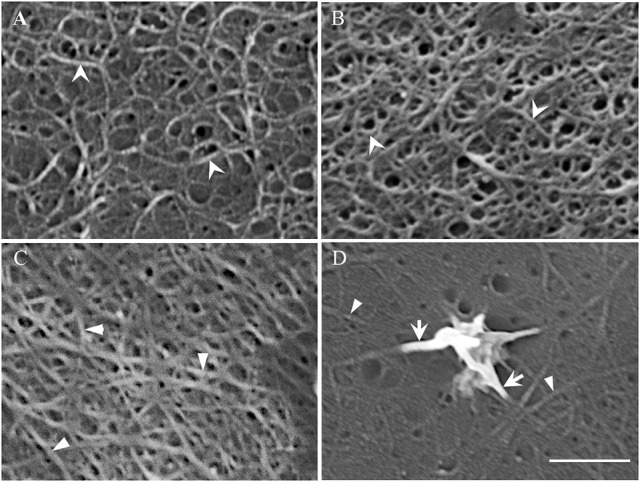
Field emission scanning electron micrographs of cellulose microfibrils viewed from the cytoplasmic face of the outer periclinal wall of adaxial epidermal cells. (A,B) Micrographs of the original wall layer obtained from (A) freshly harvested cotyledons and (B) cotyledons cultured for 15 h on 100 μM DPI to block uniform wall layer formation. (C,D) Micrographs of a fully-developed uniform wall layer obtained from cotyledons cultured for 15 h on MS medium alone. (D) In order to improve visualization of the thickened cellulose microfibrils proximal to the nascent WI papilla, excess electron charging of their surfaces was minimized by reducing the contrast setting from 43 to 30%. Cellulose microfibrils of the original (A,B) and uniform wall (C,D) layers are marked by arrowheads and darts, respectively. Arrows mark the thickened cellulose microfibrils that converge and intertwine to form WI papillae (D). Bar, 150 nm (A–C) and 100 nm (D).